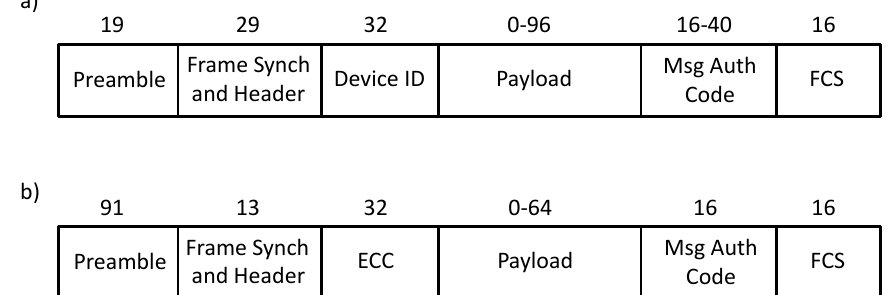
Figure 2. Sigfox frame formats: ( a ) uplink and ( b ) downlink. All frame field sizes are expressed in bits. The third frame header field starting from the left is the Device Identifier (Device ID) or the Error Correcting Code (ECC), for uplink and downlink frame formats, respectively. The two rightmost frame fields are a Message Authentication Code (Msg Auth Code) and a Frame Check Sequence (FCS).